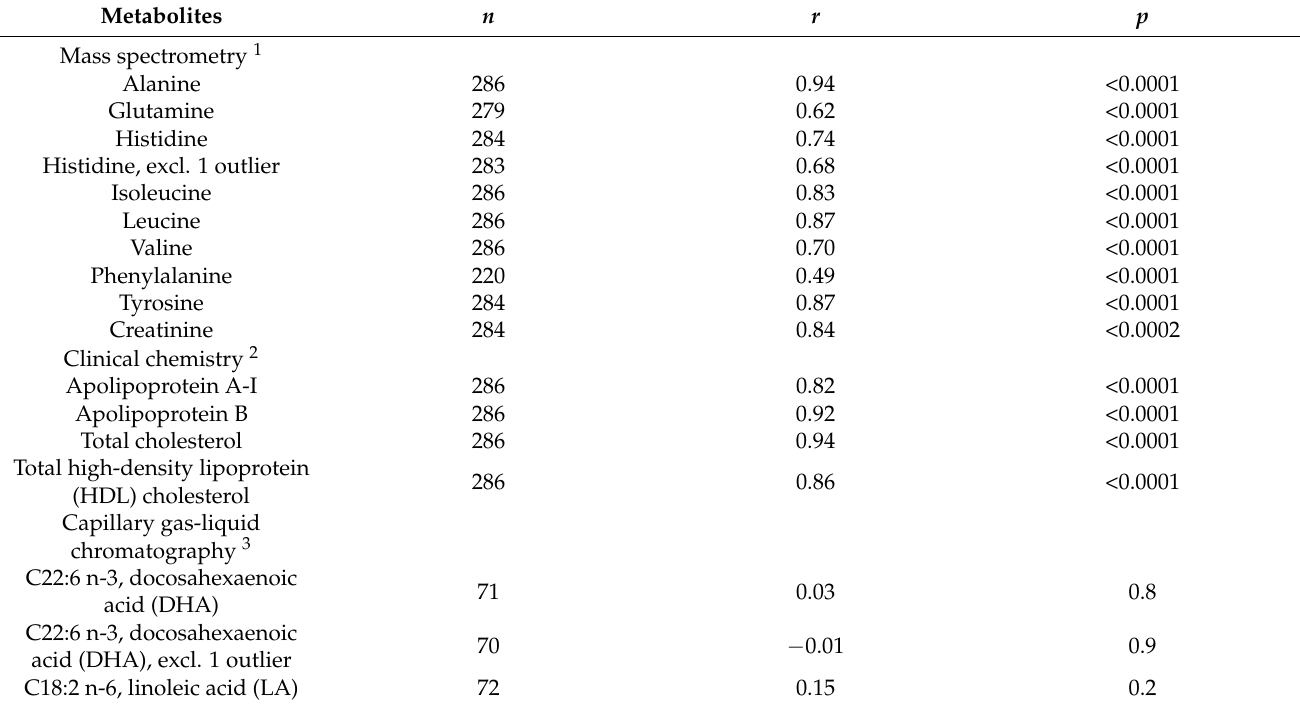
Table 3. Pearson correlations between NMR metabolite concentrations and those measured using another